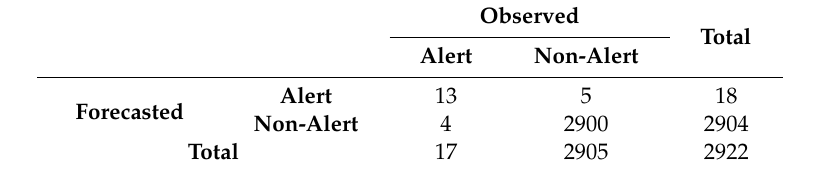
Table6. Contingencytablewiththenumberofalerteventsobservedandforecasted. Fromatotalof2922events analyzed, 13 were correct positives, five false-positives, four missed alerts, and 2900 correct negatives.